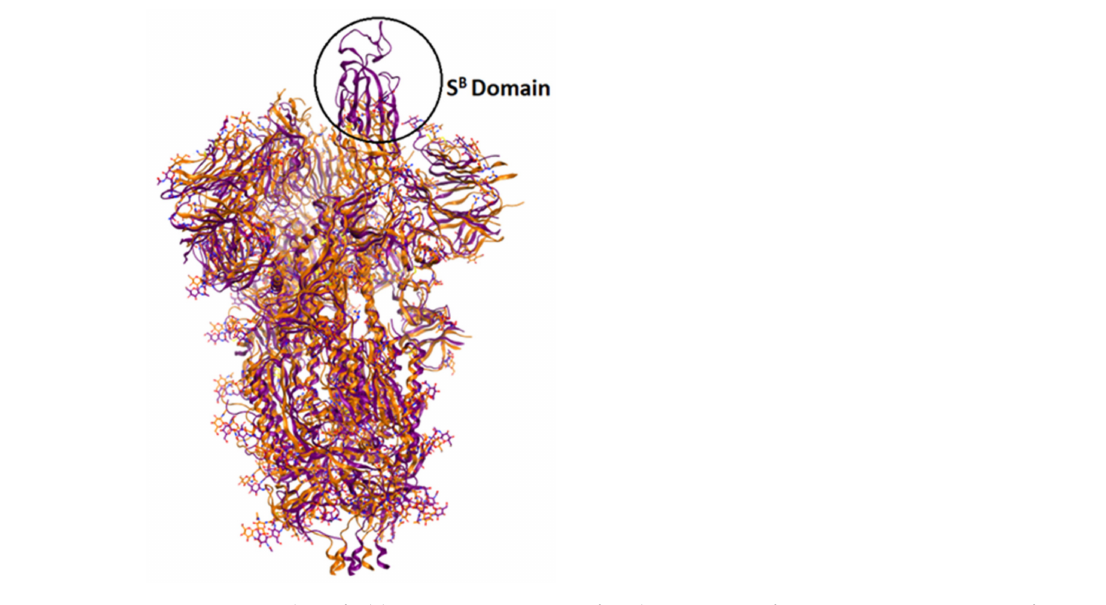
Figure 6. Overlay of ribbon representations of S-glycoprotein of SARS-CoV-2 in open conformation (in purple, PDB: 6vyb) and in closed conformation (in orange, PDB: 6vxx).